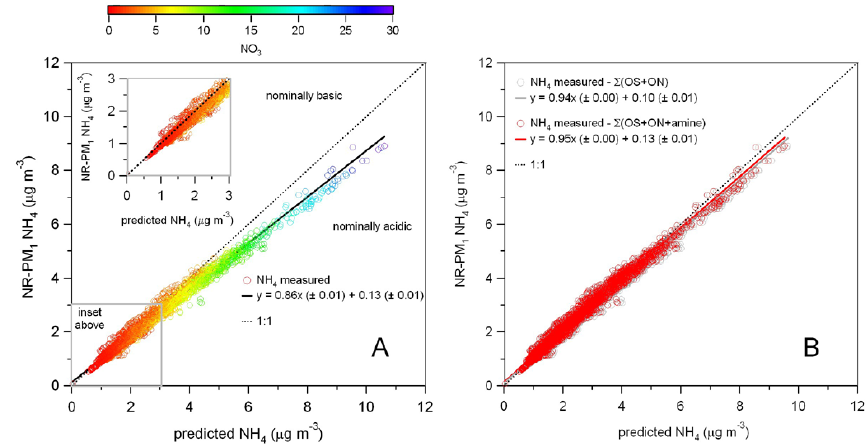
Fig. 12. Anion/cation balance based on HR-AMS measurements. In (a) , measured NH 4 is plotted against NH 4 predicted assuming full neutralization of particulate anions (e.g., NO 3 , SO 4 , and Cl). In (b) , predicted NH 4 has been adjusted to include the contributions from organonitrates, organosulfates, and amine (see text for